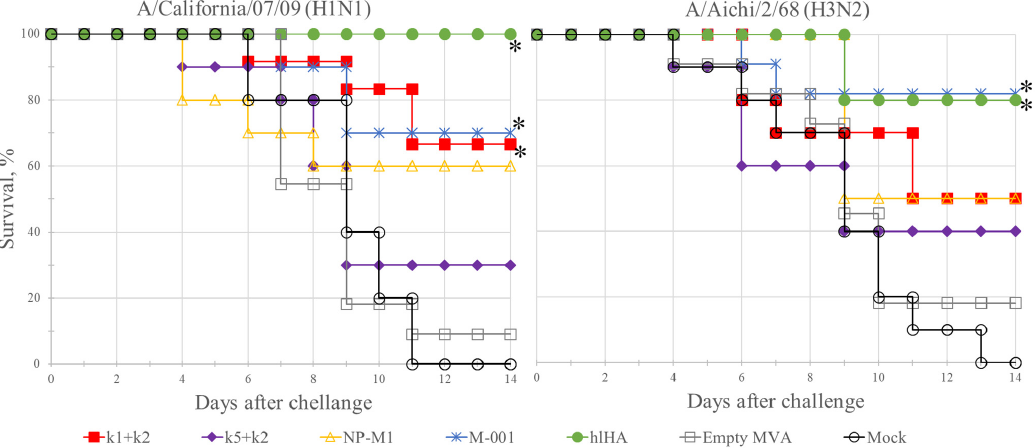
Figure 2. Kaplan–Meier survival analysis for results of infecting animals (10 to 12 mice per infected group) with the A/California/04/09 (H1N1) or A/Aichi/2/68 (H3N2) viruses after immunization with rMVAs expressing influenza virus antigens, or with wt MVA, or PBS (Mock). A statistically significant difference ( p -value < 0.05 according to the Mantel–Cox log-rank test) relative to the controls is shown with asterisk.